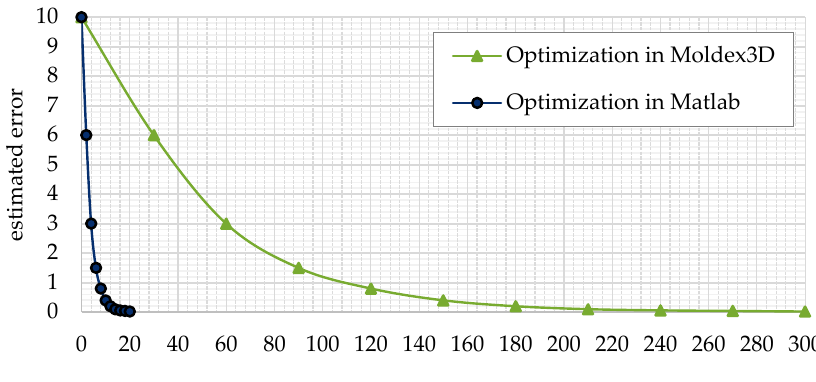
Figure 25. Comparison of calculation time of direct optimization method and the new optimization approach implemented in the fiber orientation optimization tool.